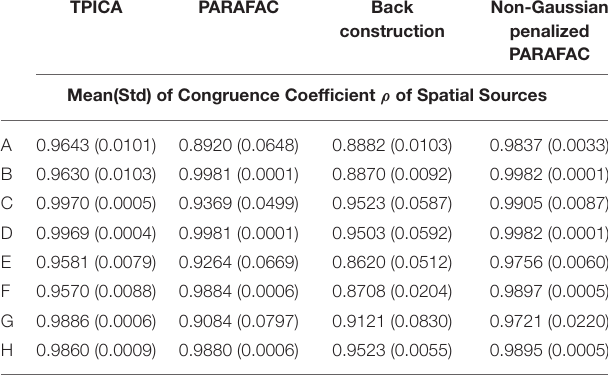
TABLE 2 | Experimental Results of the mean and std of ρ of spatial sources in all four algorithms. TPICA PARAFAC Back